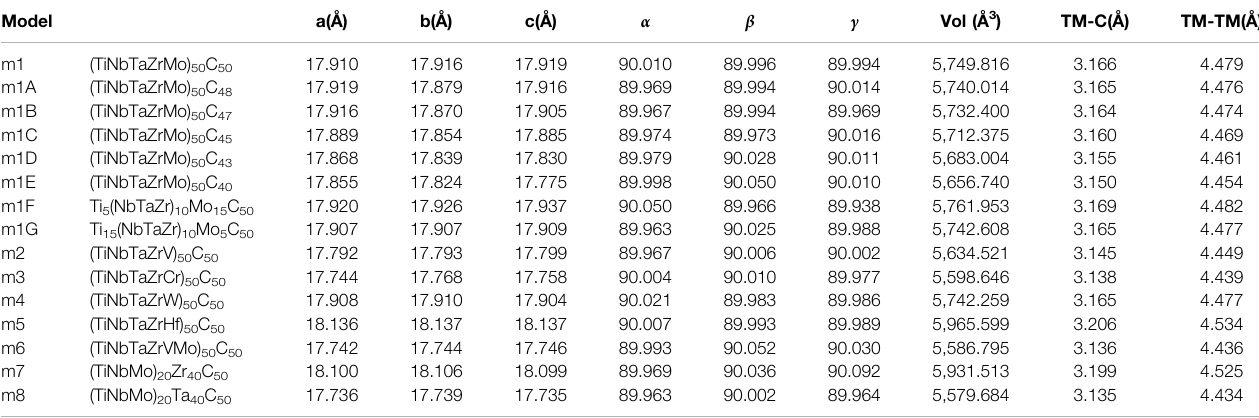
TABLE 1 | 15 rock-salt face centered cubic HEA models.